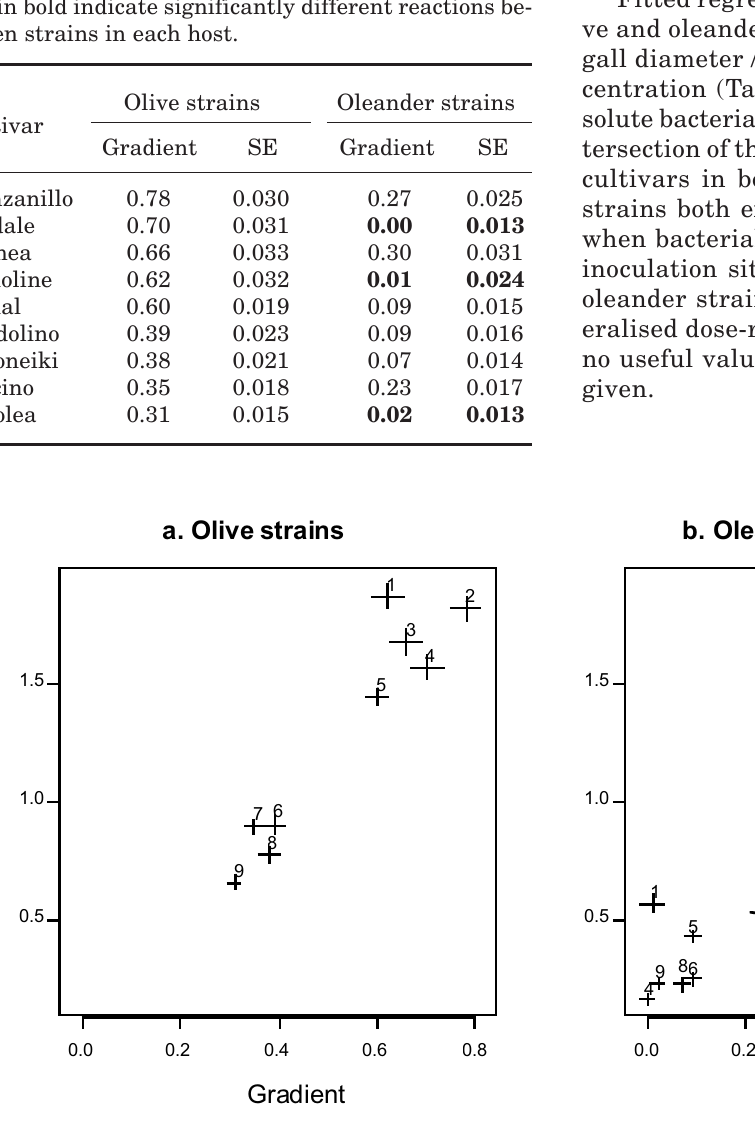
Fig. 1. Mean gall diameters (mm) in nine olive cultivars inoculated with P. savastanoi olive knot strains ICMP 13519 and 13813 (a), and oleander strains ICMP 791 and 13815 (b), at 3 (cid:1) 10 6 cfu ml -1 , plotted versus gradient expressed as change in gall diameter / ten-fold change in inoculum concentration. Cultivar: 1, Picholine; 2, Manza- nillo; 3, Barnea; 4, Verdale; 5, Picual; 6, Pendolino; 7, Leccino; 8, Koroneiki; 9, Carolea. Each bar represents ± standard error of estimated values of the gradient and gall diameter. If the bars for the gradients of two cultivars do not overlap, it is concluded that they are significantly different ( P